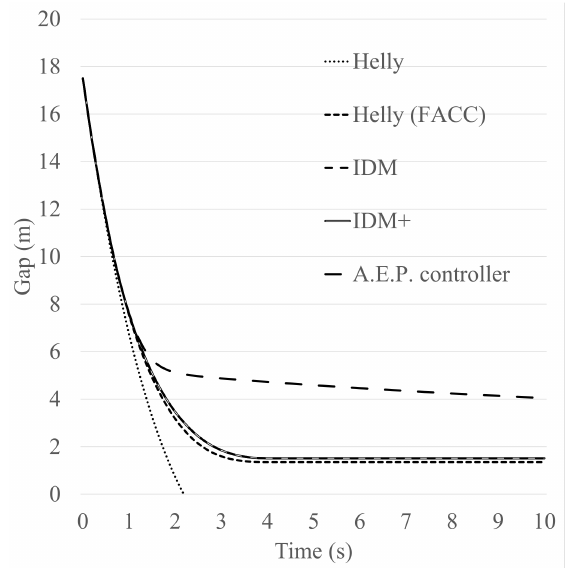
Figure 12. The following vehicle’s gap transition of case